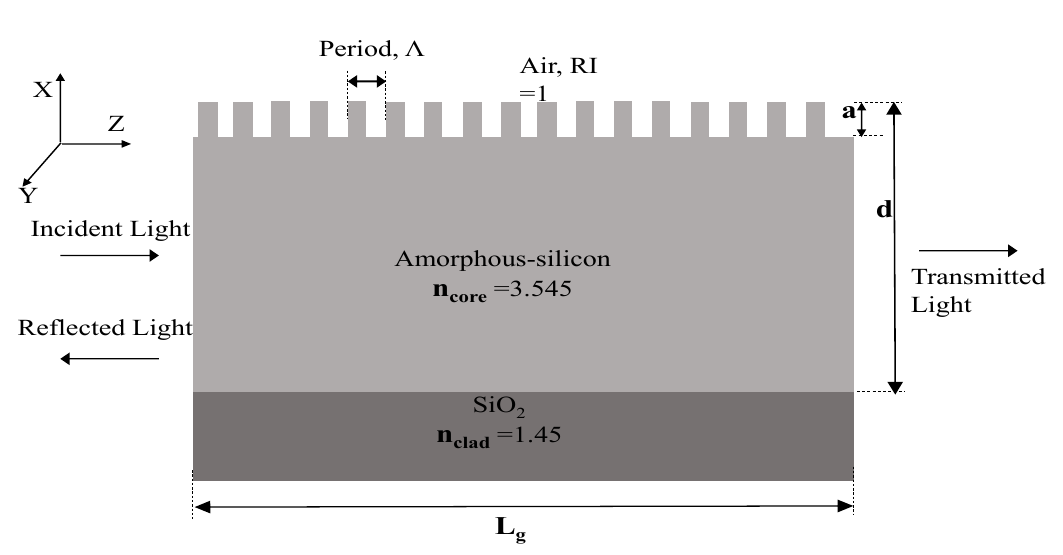
Figure 5. Longitudinal cross-section view of surface-relief waveguide Bragg